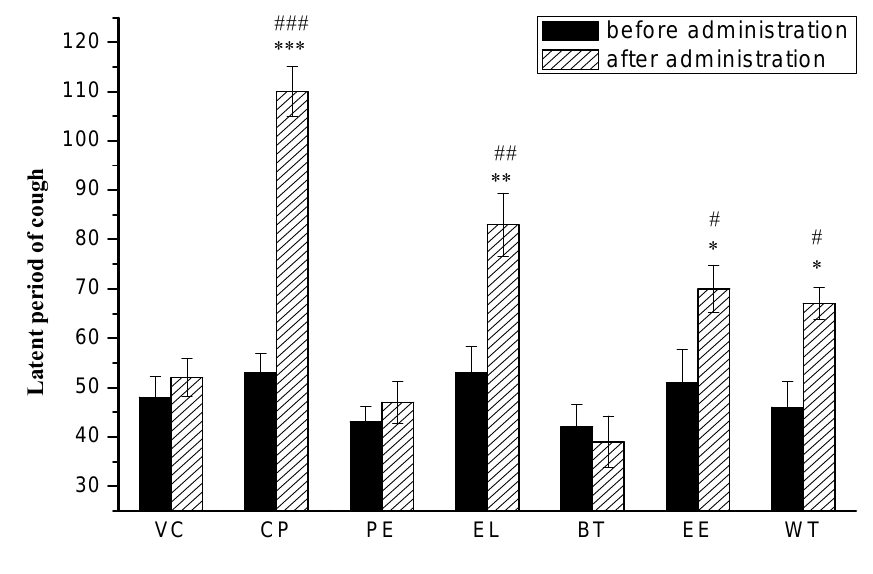
Figure 3. Latent period of cough of VC, positive codeine phosphate (CP), PEF (PE), EtOAcF (EL), n -BuOHF (BT), EtOHE (EE), WE (WT) at 400 mg/kg (i.g). * p < 0.05, ** p < 0.01, compared with vehicle control after administration; # p < 0.05, ## p < 0.01, compared with data before administration, n =